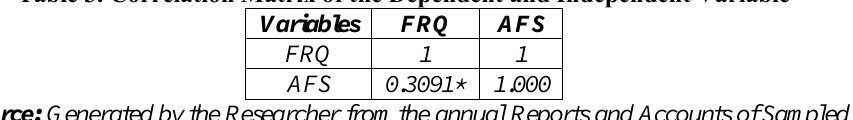
Table 3. Correlation Matrix of the Dependent and Independent Variable Variables